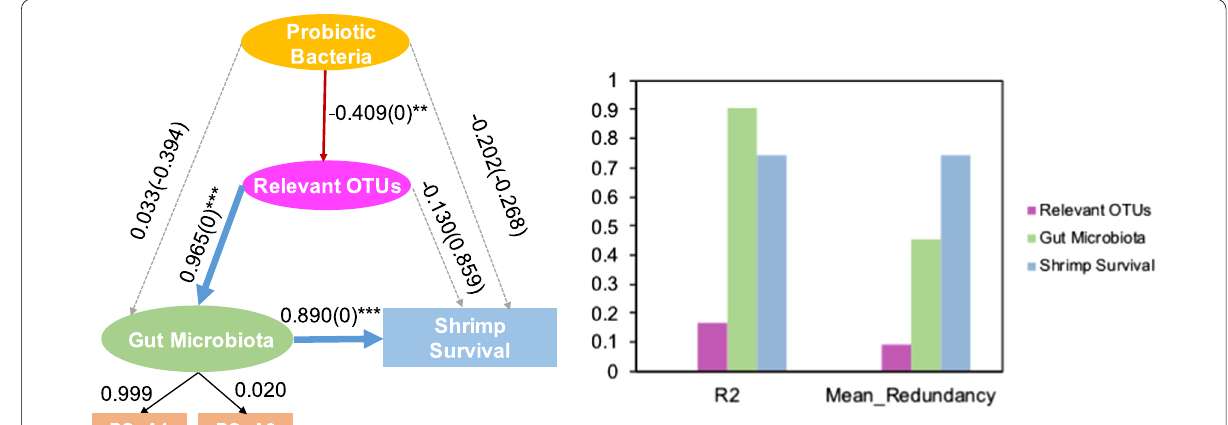
Fig. 7 The final path of partial least squares path model (PLS-PM) quantification of the direct and indirect effects of probiotic bacteria and relevant OTUs on gut microbiota, based on Bray–Curtis distance and shrimp survival. Blue and red lines represent positive and negative effects, respectively. Dashed lines indicate the coefficients that did not significantly ( P > 0.05) differ from 0. The wider the line, the higher the absolute value of the coefficient obtained with PLS-PM. (** P < 0.01; *** P <